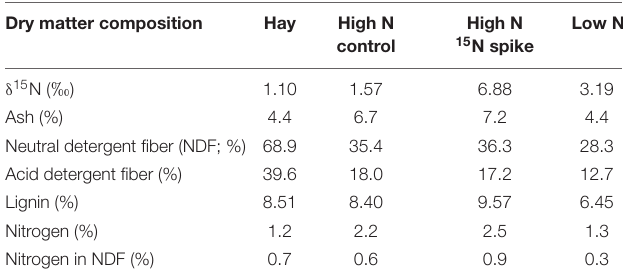
TABLE 1 | Composition of foods provided to reindeer, caribou, and muskoxen from February to April 2009 in Fairbanks, AK, United States. Dry matter composition Hay High N